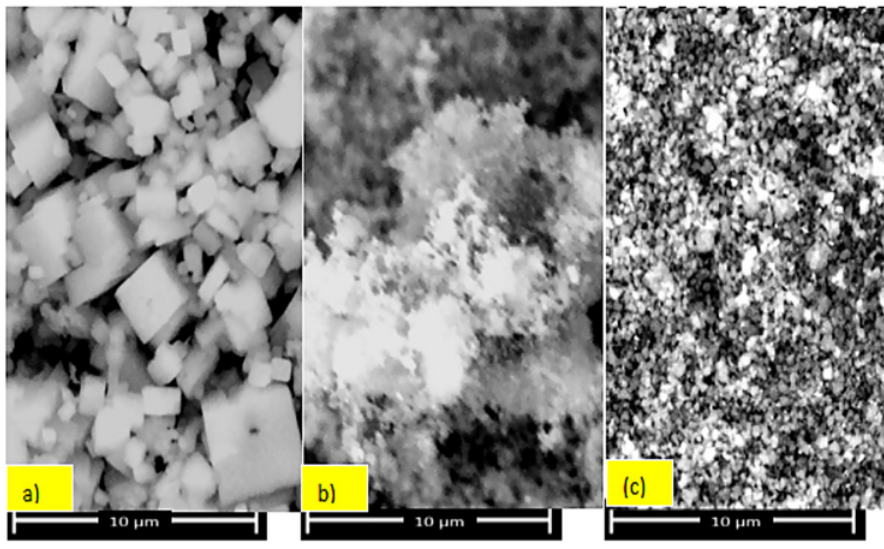
Fig 2. SEM images of (a) the Fe(byp) complex, (b) ZSM-5, and (c)